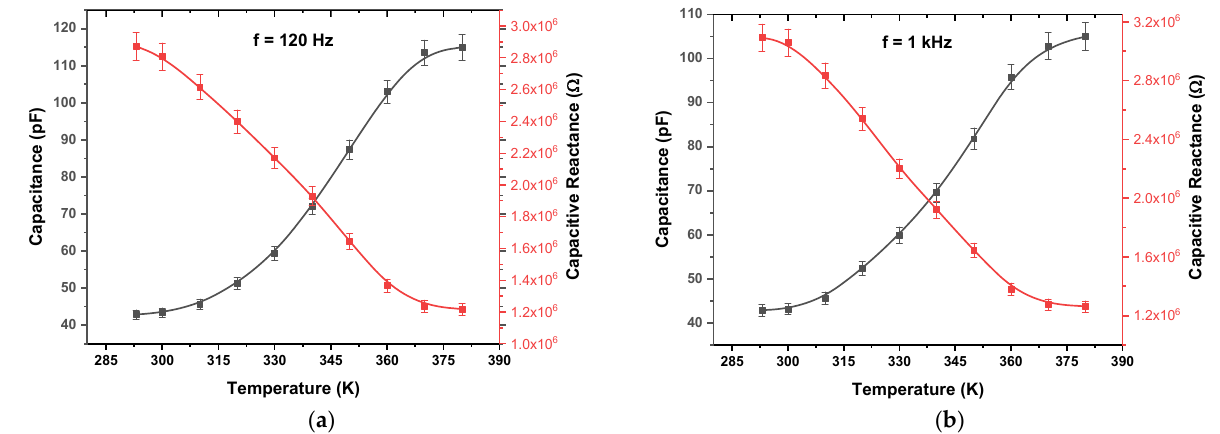
Figure 9. Effect of temperature on capacitance and reactance of Ag/PAD/Ag sensor at ( a ) 120 Hz and ( b ) 1 kHz.